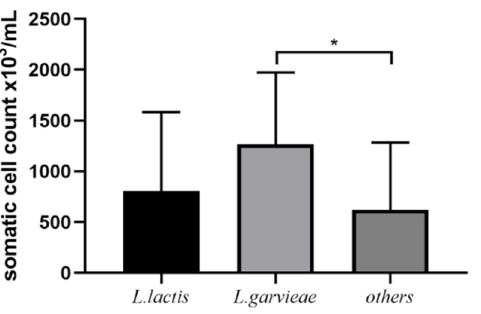
Figure 3. Post-treatment SCC of L. lactis vs. L. garvieae or others (includes L. lactis ). * indicates a significant difference between different groups ( p < 0.05 by ANOVA test).